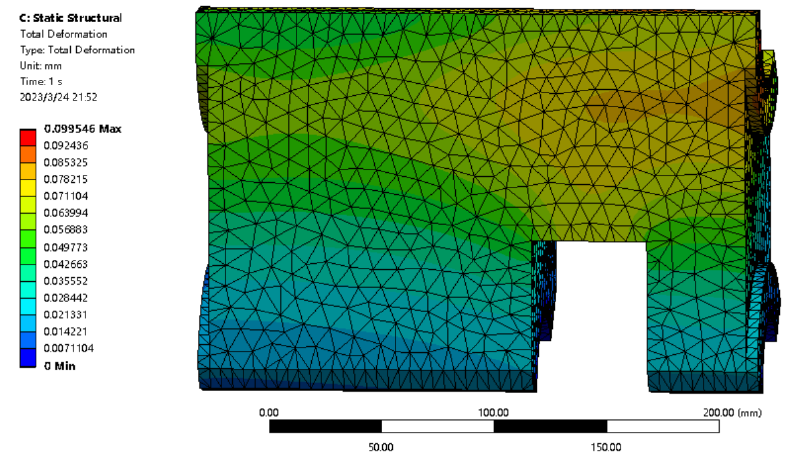
Figure 8. Deformation of solid drive rod.